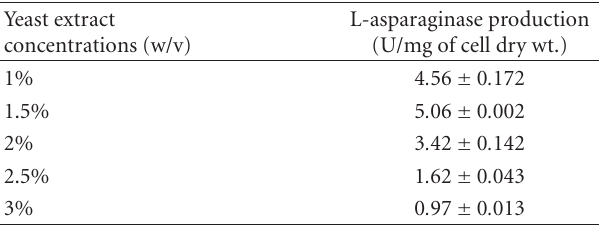
Table 4: Impact of yeast extract concentrations on L-asparaginase production by Nocardia levis grown in modified ISP-5 broth.